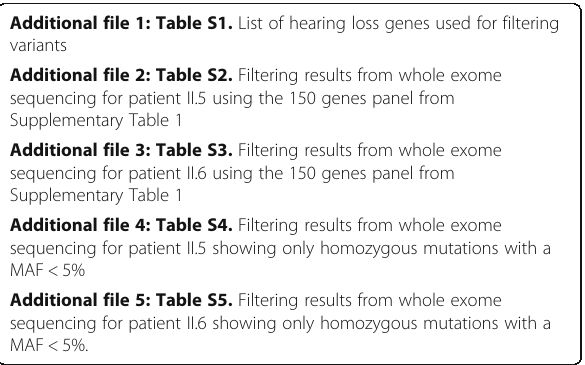
Additional file 4: Table S4. Filtering results from whole exome sequencing for patient II.5 showing only homozygous mutations with a MAF< 5% Additional file 5: Table S5. Filtering results from whole exome sequencing for patient II.6 showing only homozygous mutations with a MAF<